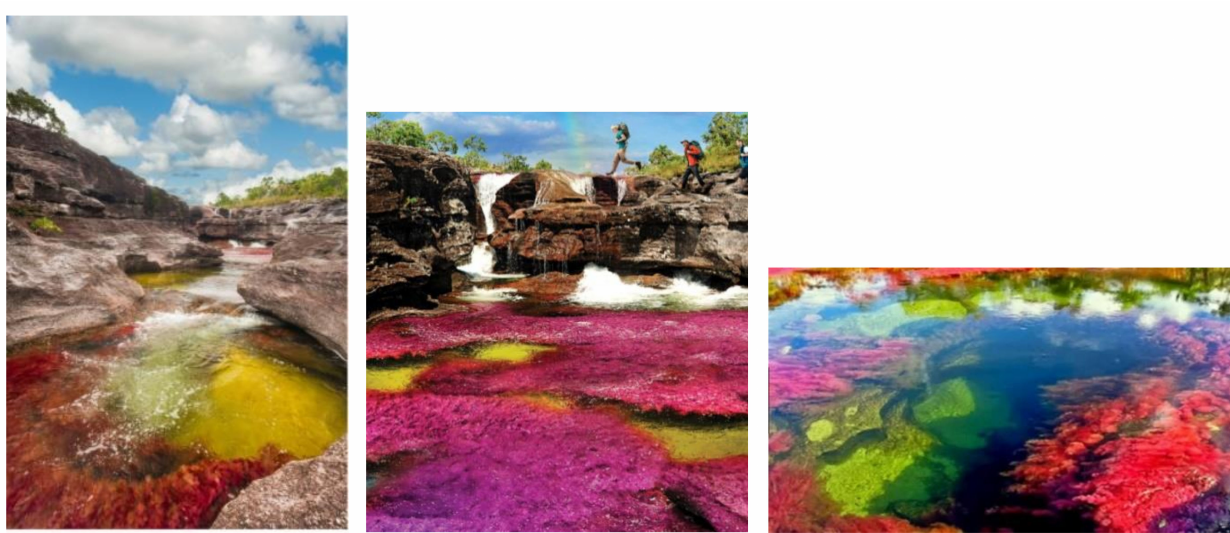
Figure 3. El Caño Cristal (La Macarena, Dep.tp Meta, Colombia) (source: http://www.cano-cristales.com/, accessed on 8 May